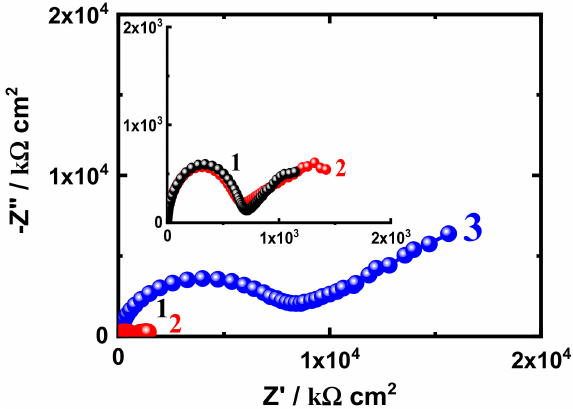
Figure 11. Nyquist plots obtained for (1) SN1, (2) SN3, and (3) SN5 after their immersion for 30 days in 3.5% NaCl